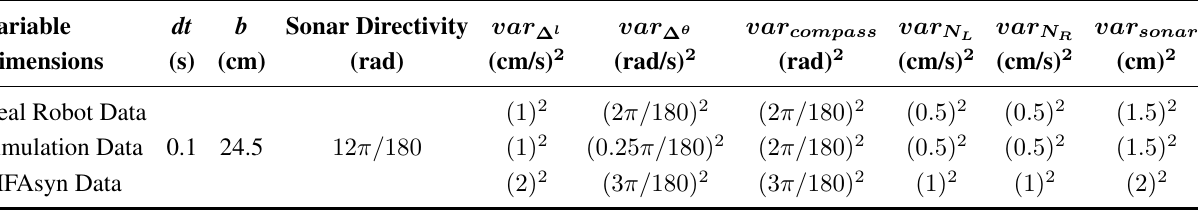
Table 2. Constants and Variances of the